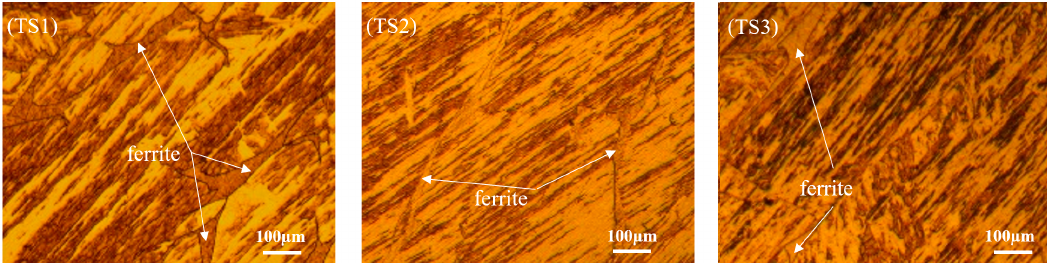
Figure 7. Microstructure at positions of 50 mm away from the surface of three TS samples.